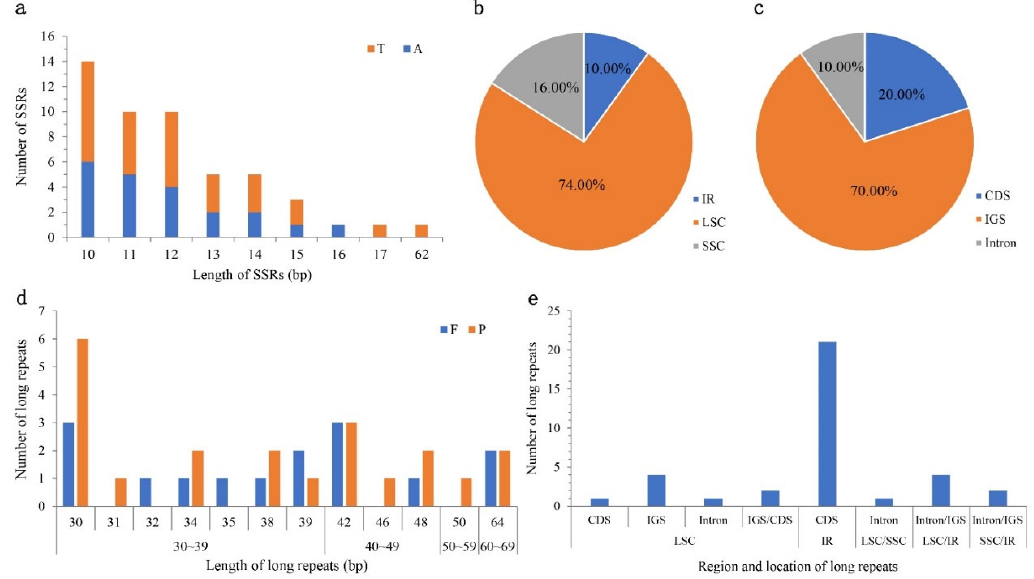
Figure 2. The type, frequency, and distribution of simple sequence repeats (SSRs) and long repeated sequences in the chloroplast genome of C . ‘Xiari Qixin’: ( a ) Frequency of different SSR repeat motifs by length. A, A base. T, T base; ( b ) Proportion of SSRs in different regions; ( c ) Proportion of SSRs in different locations. IGS: intergenic space; CDS: protein ‐ coding regions; ( d ) Frequency of different lengths in long repeats. F: Forward repeat, P: Palindrome repeat; ( e ) Frequency of long repeats by